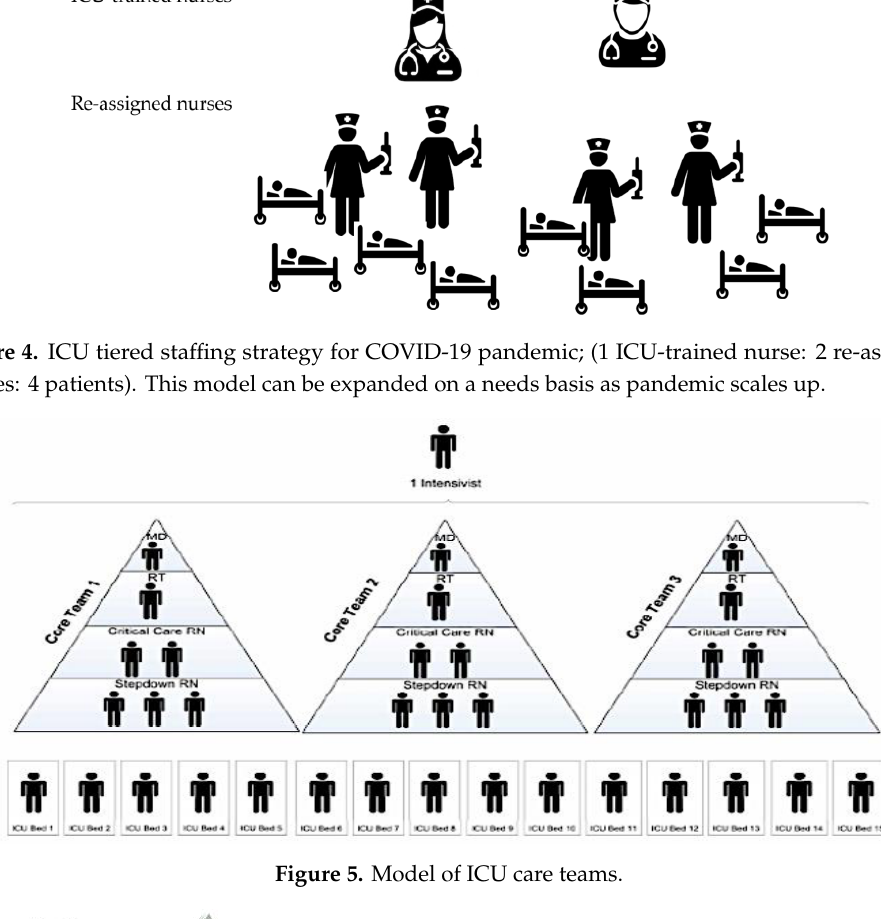
Figure 5. Model of ICU care teams.